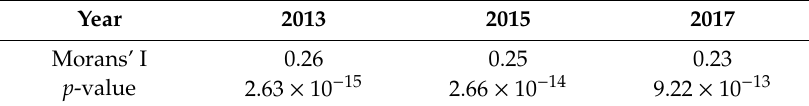
Table 13. Morans’ I of China prefecture-level